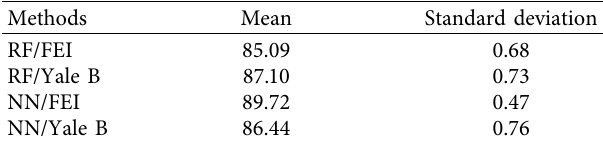
Table 4: The mean and standard deviation results for the FLBP methods using the random forest and the neural network (NN) classifier with the FEI dataset and the Yale B dataset.